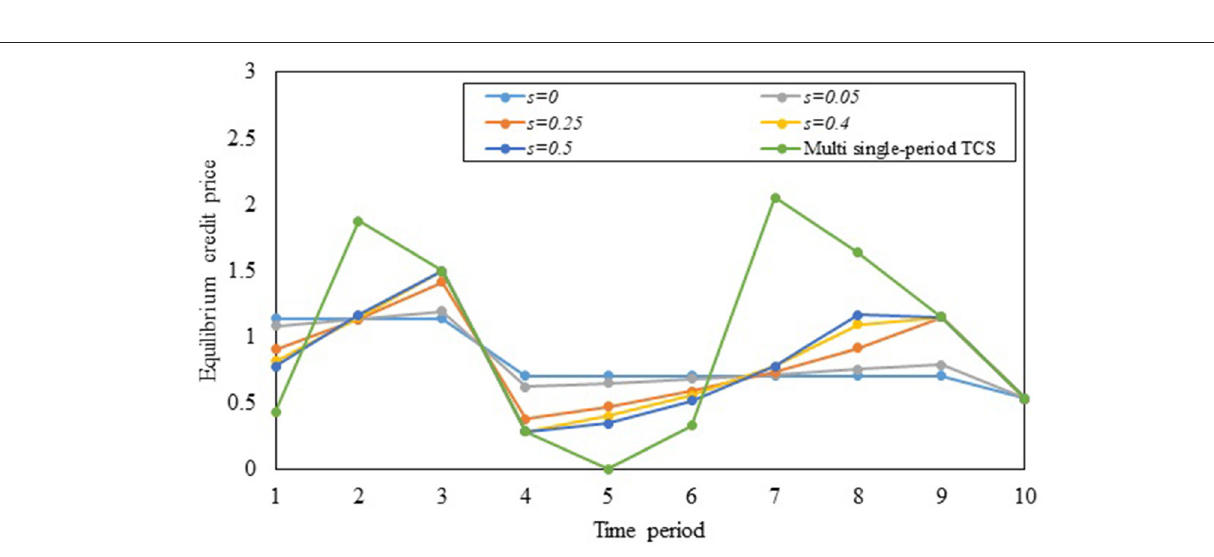
FIGURE 4 | Impact of interest rate on the evolution of multi-period equilibrium credit price.